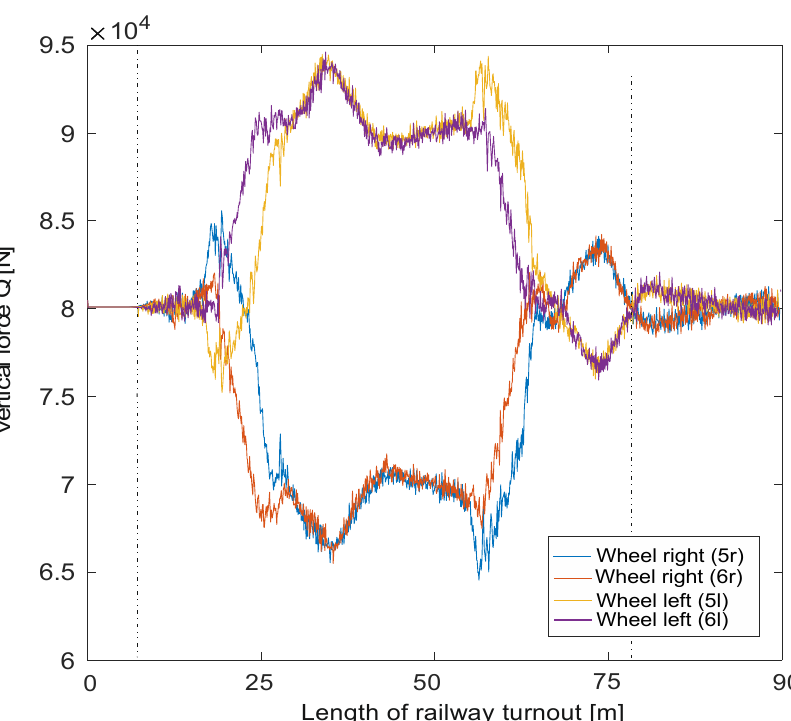
Figure 7. Vertical force on wheels at 150 km/h on a straight track through a turnout.